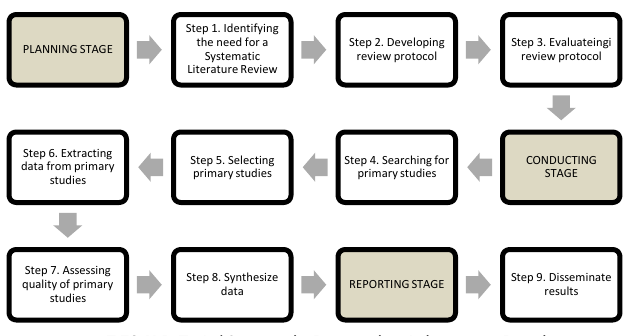
FIGURE 1 | Stages in Reporting Literature